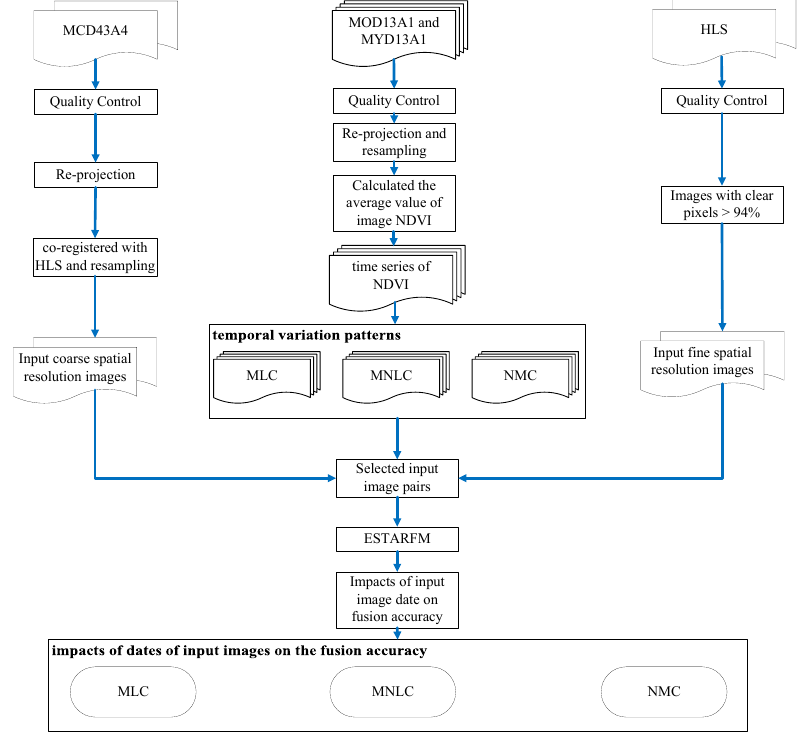
Figure 5. Flowchart of